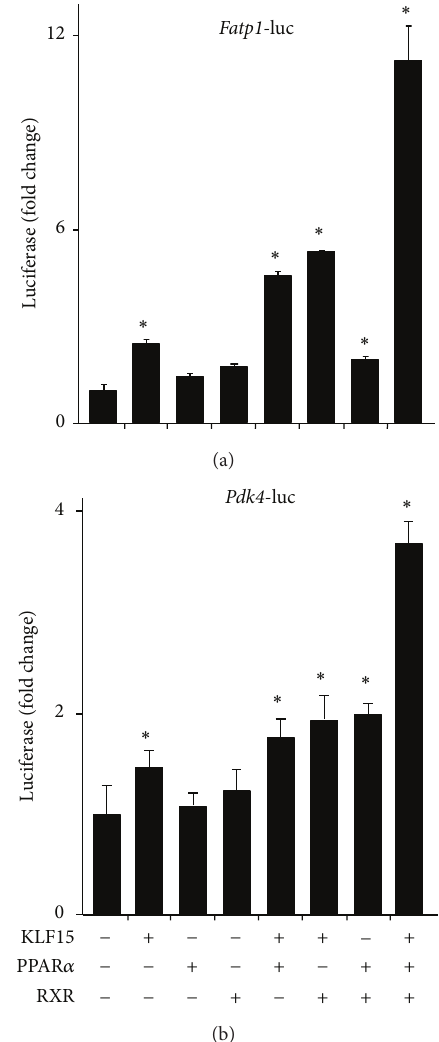
Figure3:KLF15cooperateswithPPAR 𝛼 toregulatecanonicaltarget promoters. Cooperative promoter induction between KLF15 and PPAR 𝛼 on − 1.2kb Fatp1-luciferase (a) and − 1.6kb Pdk4 -luciferase (b) in transfected NIH-3T3 cells ( 𝑛 = 6 ). ∗ 𝑃 < 0.05 versus mock